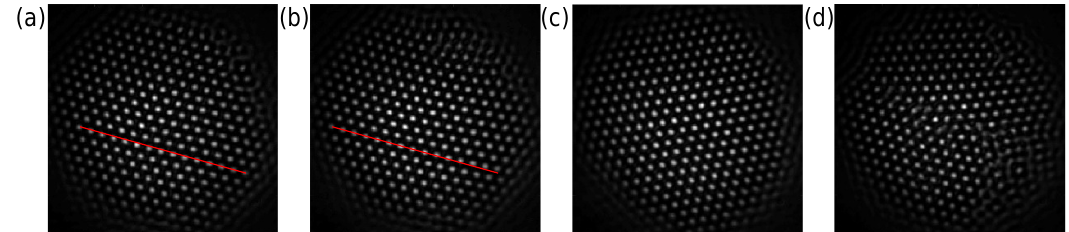
Figure 3. Examples of hexagonal patterns observed in a parameter range in which optomechanical and electronic nonlinear- ities are both present. The different structures appeared in different realizations of the experiment under nominally the same experimental conditions illustrating spontaneous symmetry breaking. ( a – c ) differ in the orientation of hexagonal axes. This difference is very small between ( a , b ) (the red line indicating an axis in ( a ) is not aligned with a row of spots in ( b )), but very obvious between ( a )/( b ) and ( c ). ( d ) contains two different domains consisting of the hexagons in ( a , c ) with a defect line in between them. Parameters: I in = 250 mW/cm 2 , δ = + 7 Γ , and d = 5